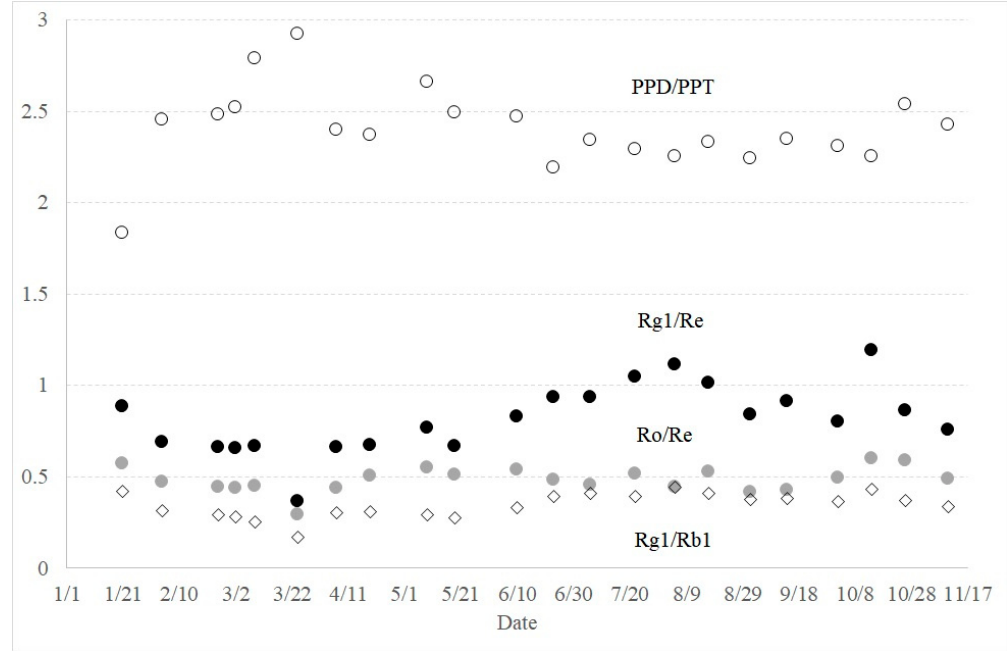
Figure 4. Seasonal variations of the ratios of PPD over PPT (open circle), ginsenosides Rg1 over Re (closed circle), ginsenosides Ro over Re (shaded circle), and ginsenoside Rg1 over Rb1 (diamond) throughout the year.